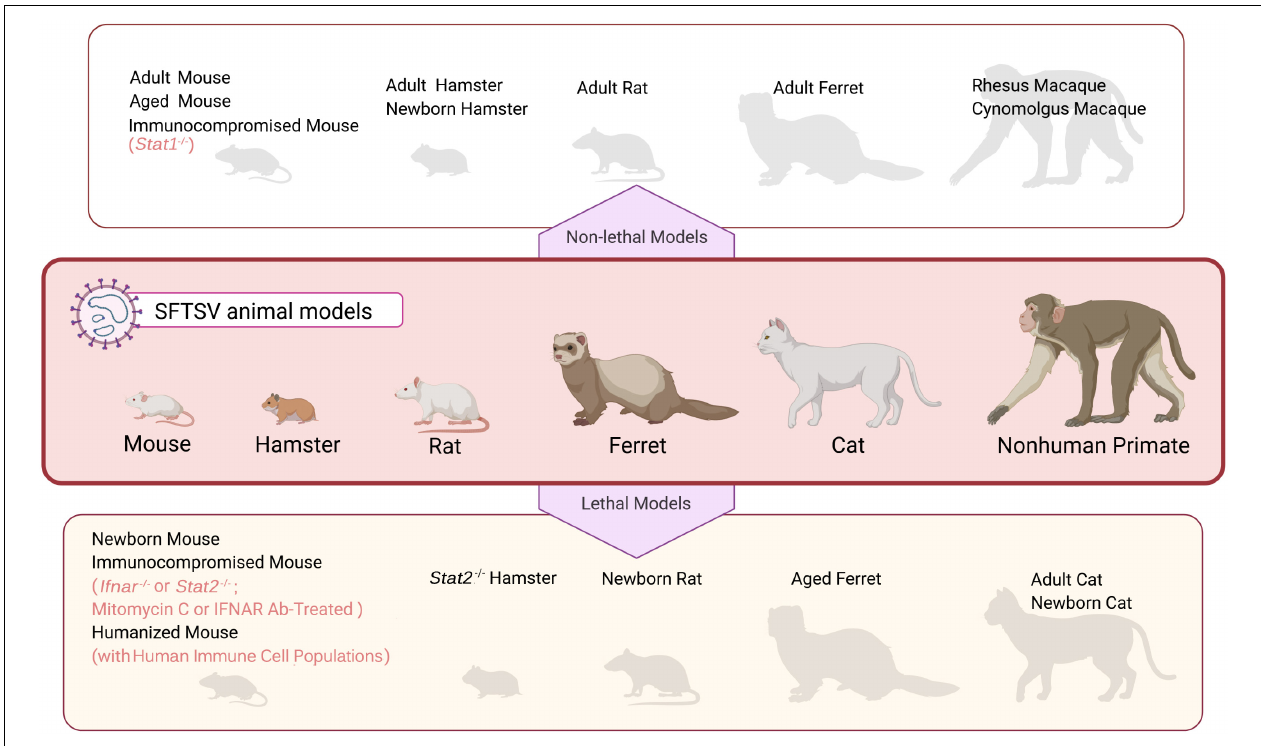
FIGURE 1 | An overview of SFTSV animal models. Mammalian species that have been used in SFTSV research are illustrated in the middle panel. These animal models can be grouped into two categories, “non-lethal models” (upper panel) and “lethal models” (bottom panel), depending on whether SFTSV infection causes death in the animals. See text for